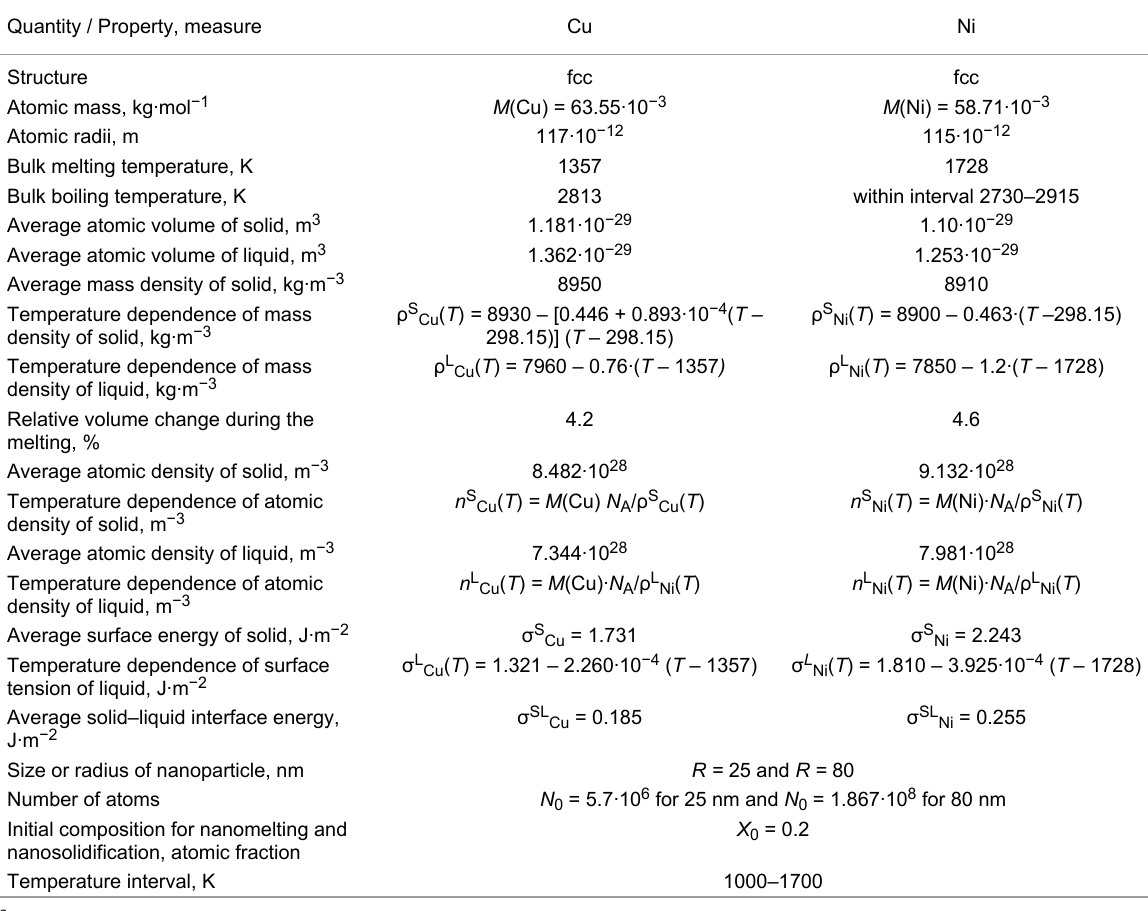
Table 1: The parameters and physico-chemical properties used in calculation of Cu–Ni system [25-39]. a